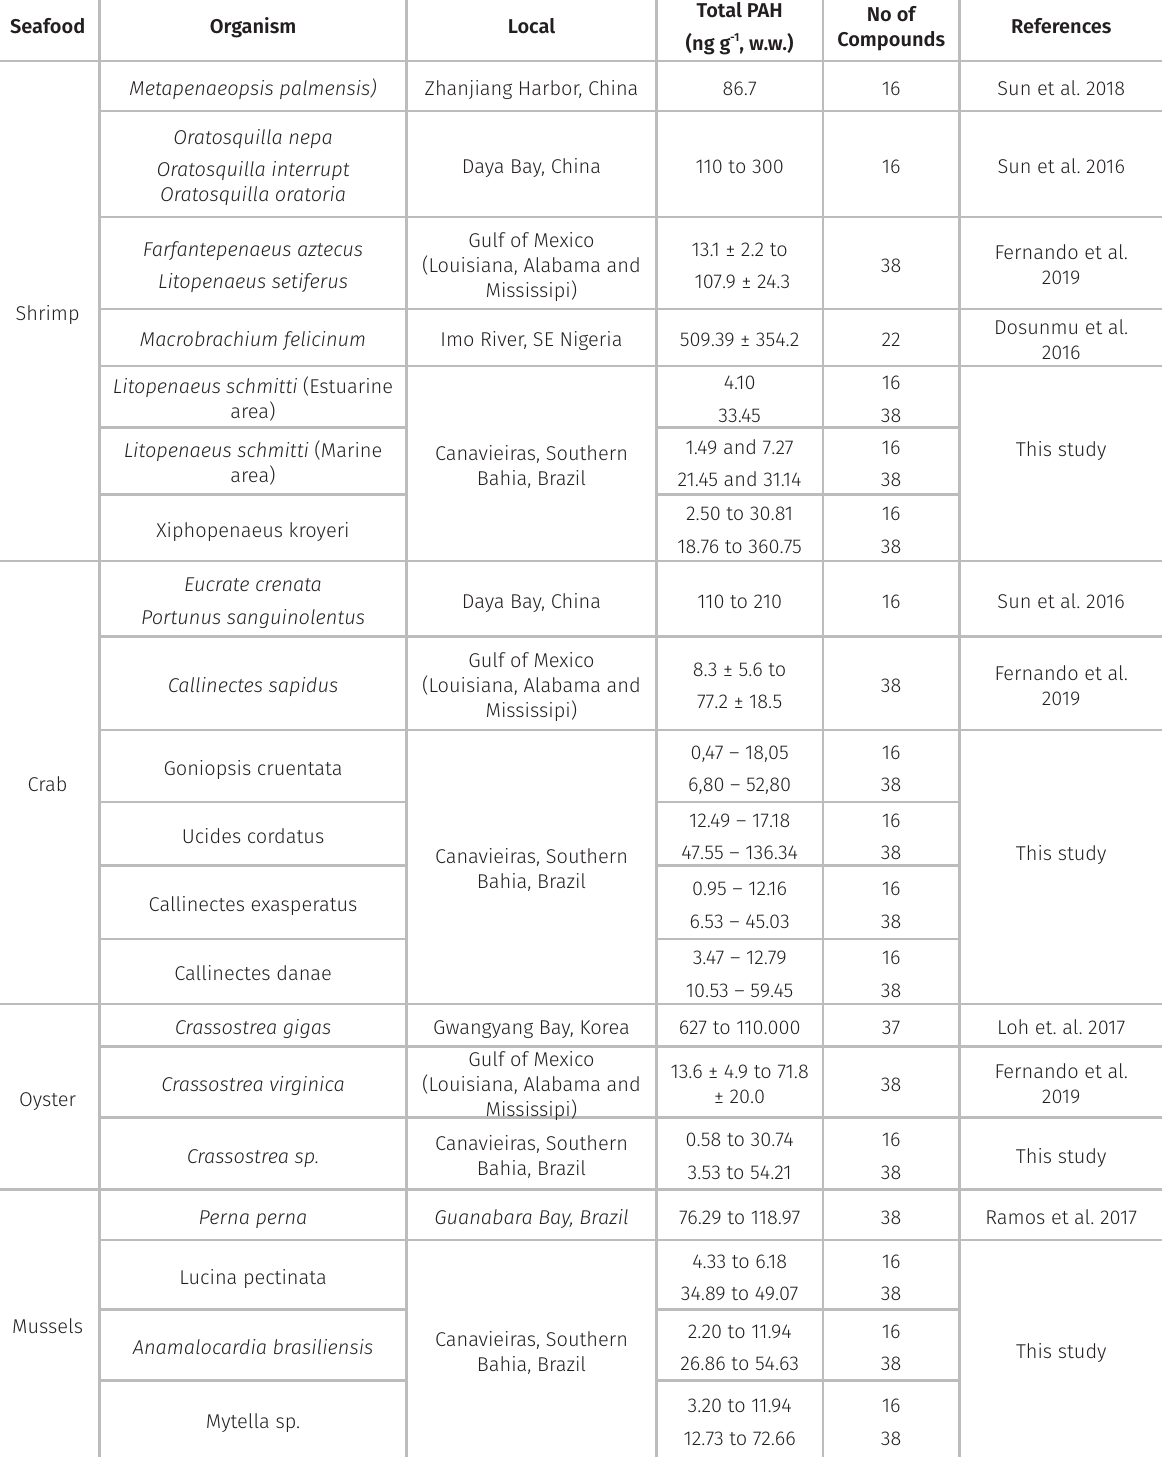
Table II. Data compilation for total PAH concentrations in crustaceans, molluscs and fish of Brazilian and worldwide coastal